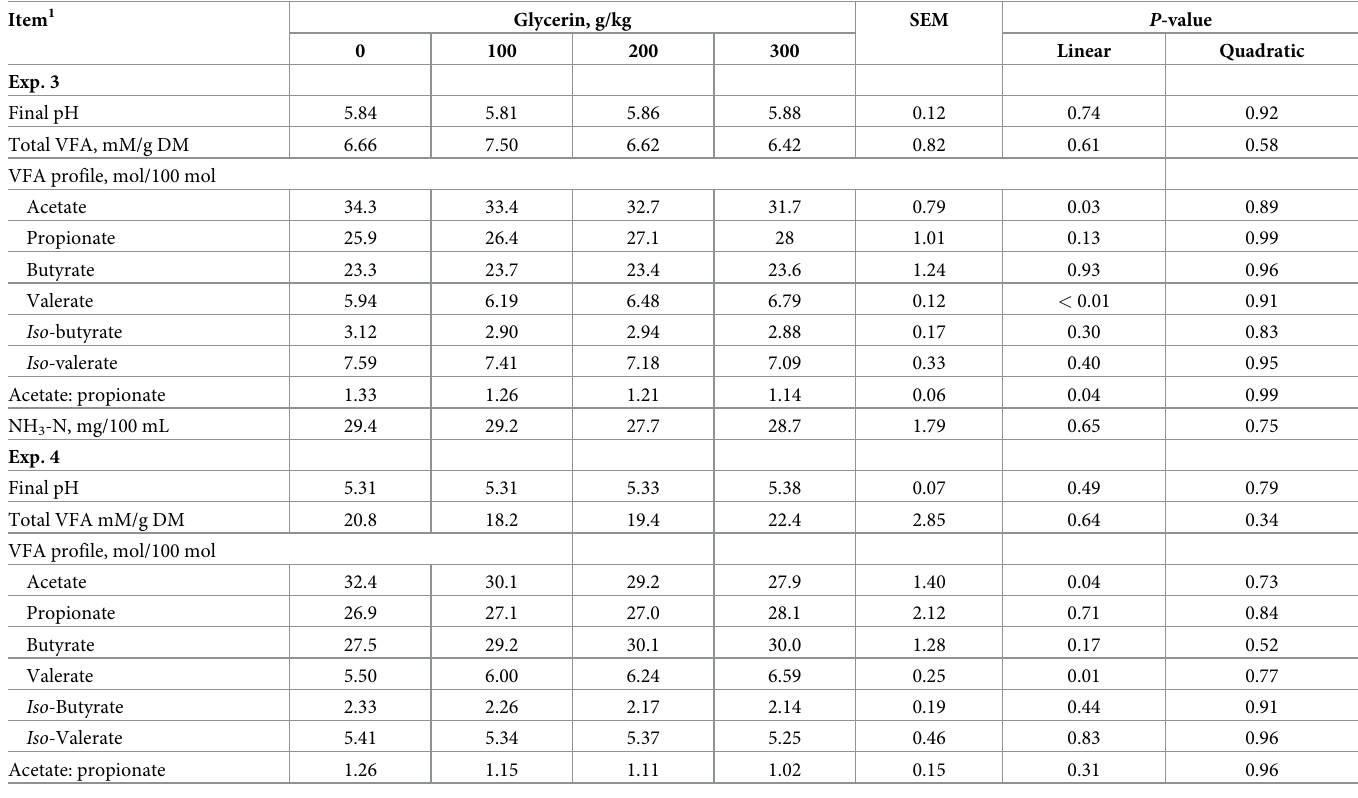
Table 5. Effects of dietary glycerin inclusion on ruminal variables in gas production